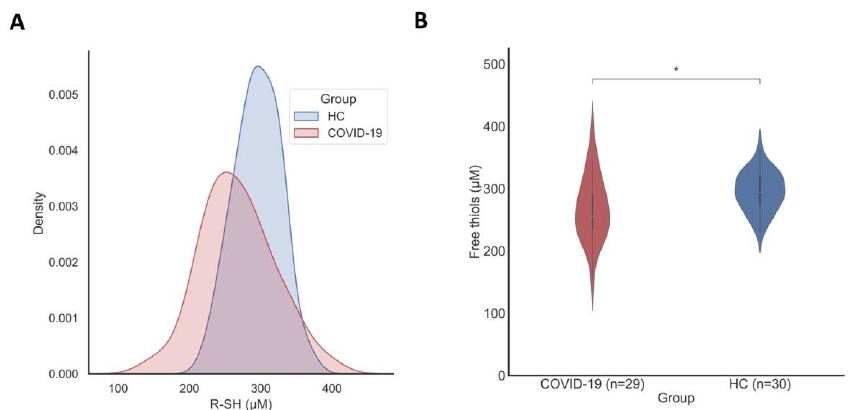
Figure 1. ( A ) Kernel density estimation of the distributions of serum free thiol concentrations among subjects with mild COVID-19 and healthy controls, demonstrating a normal distribution in both groups. Density estimates were performed using a Gaussian kernel. ( B ) Baseline serum concentrations of free thiols ( µ M) are significantly reduced in subjects with mild COVID-19 as compared to healthy controls (* p =